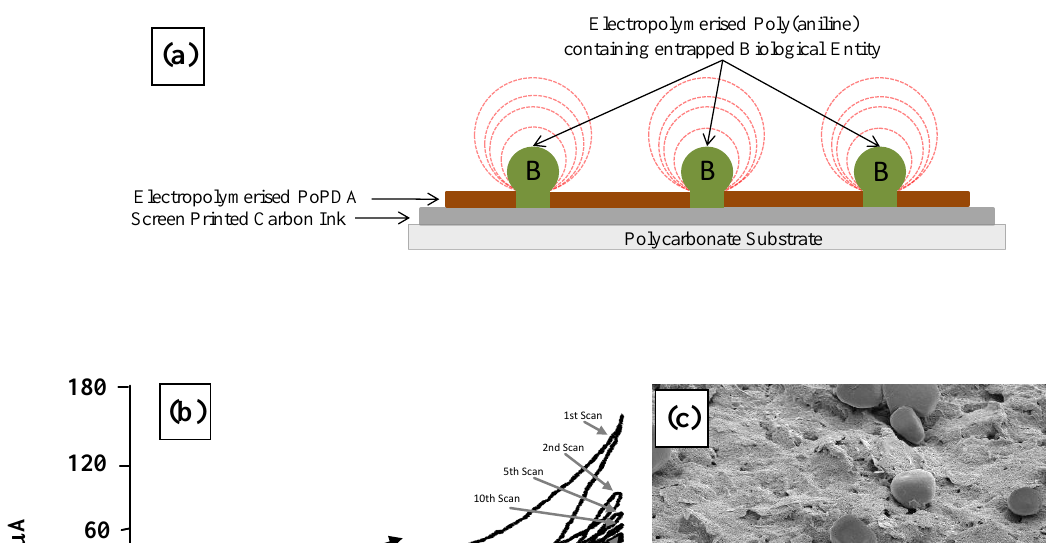
Figure 7. Generation of enzyme containing-poly(aniline) protrusion microelectrode arrays. (a) Schematic of sonochemically fabricated poly(aniline)/microelectrode array; (b) cyclic voltammetry (50 mV s –1 ) for electropolymerisation of poly(aniline) and co-entrapment of glucose oxidase; (c) Scanning electron micrograph of sonochemically fabricated poly(aniline) enzyme microelectrode